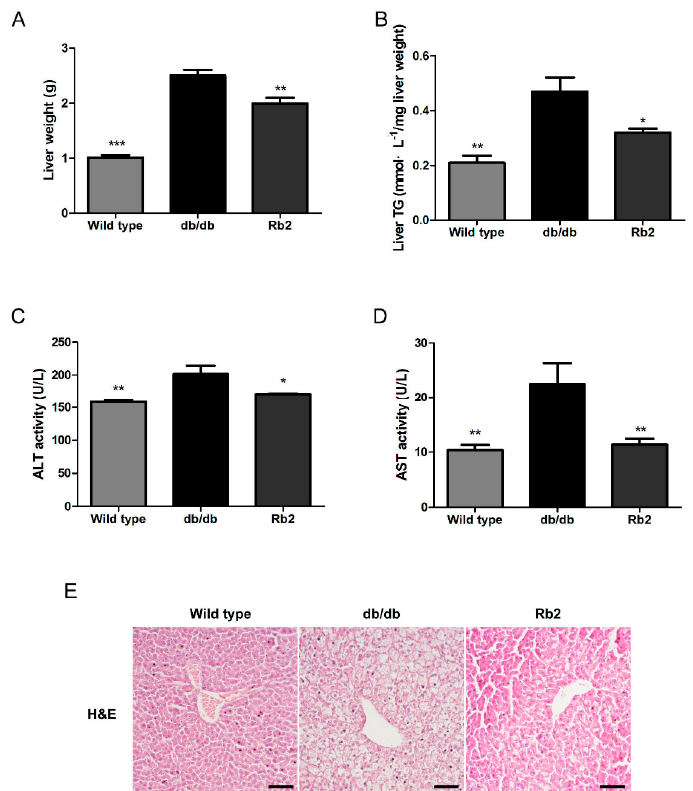
Figure 2. Rb2 attenuated hepatic steatosis in db/db mice. At the end of the 4-week administration, the effect of Rb2 on liver weight ( A ) and triglycerol (TG)content of the liver ( B ) in wild type and db/db mice were assessed. Serum levels of alanine aminotransferase (ALT, C ) and aspartate aminotransferase (AST, D ) were calculated. Liver sections were stained with hematoxylin and eosin (H&E), and representative images around the perisinusoidal spaces were captured (Scale bars = 100 µ m) ( E ). Wild type: Wild type mice as normal control, db/db: Vehicle-treated db/db mice, Rb2: Rb2 (10 mg/kg body weight)-treated db/db mice. Data are expressed as mean ± SE from 10 animals per group. * p < 0.05 and ** p < 0.01 compared with db/db group.